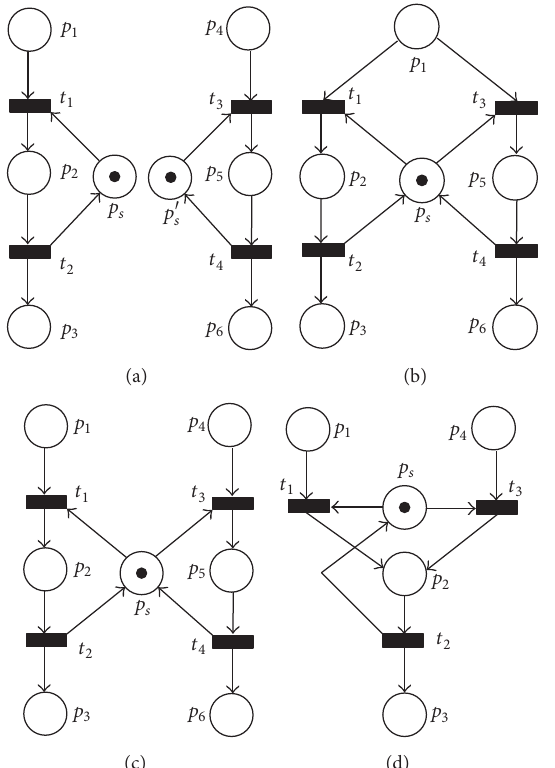
Figure 2: (a) Two linearity processes with two special resources, (b) an MESR with dispersive pattern, (c) an MESR with parallel pattern, and (d) an MESR with polymeric